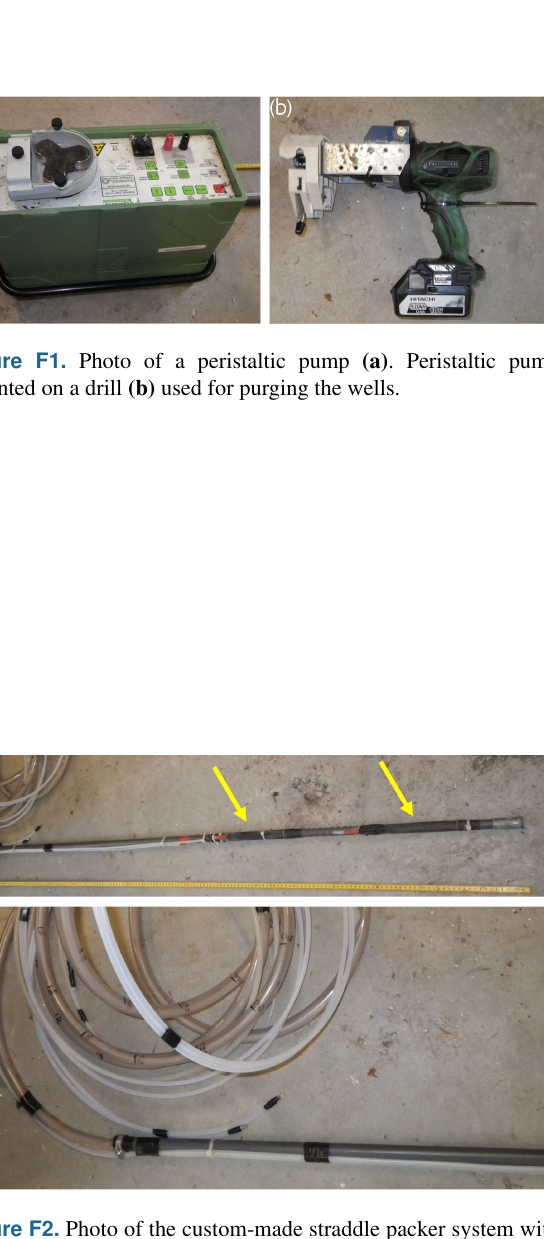
Figure F2. Photo of the custom-made straddle packer system with two inflatable parts to isolate specific depths in the wells and to pump water from a specific depth (a) . The upper part and tubing system (pumping tube and two air tubes to inflate the flexible tube parts) of the packer system (b) . The yellow arrows in panel (a) in- dicate to the inflatable packer system parts that sealed off (i.e., iso- lated) water above and below the selected sample